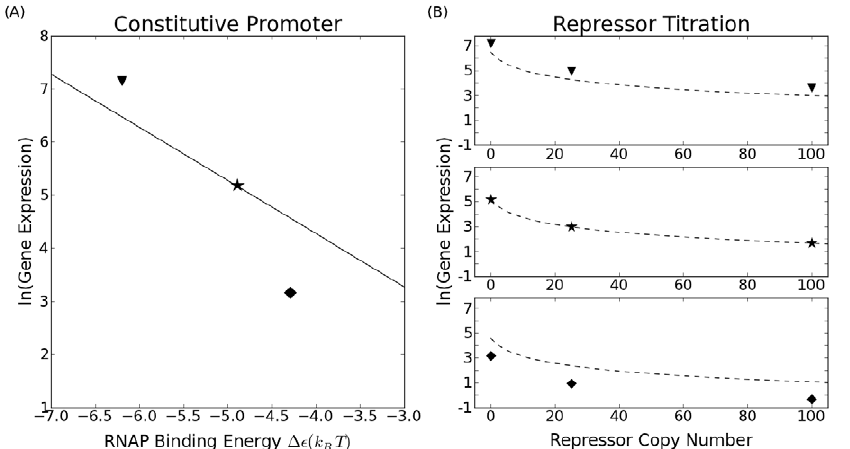
Figure 6. Expected relation between predictions and measurement for simple repressor titration. Figure (A) shows three hypothetical promoters for which the predictions of the promoter design are either numerically correct ( ? ), underestimated ( . ) or overestimated ( % ). The three smaller figures in (B) show the expected result as repressors are added in a simple repression architecture. The predicted theory line and the data points differ on average by the same percent as they do at R ~ 0